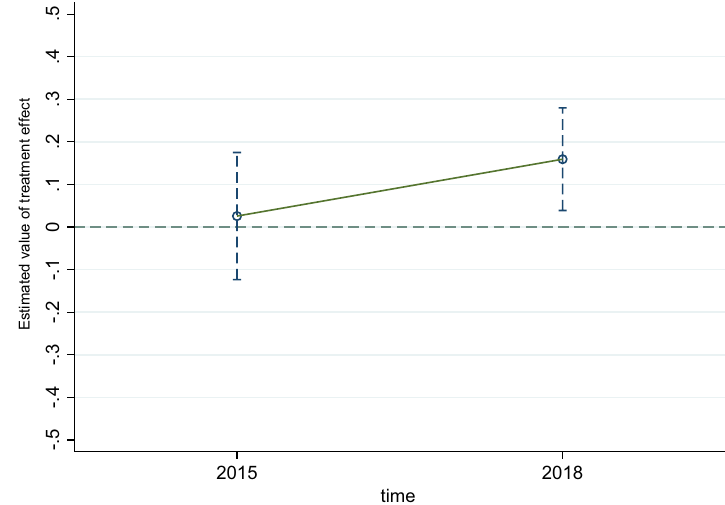
Figure 1. Parallel trend test—total residents.